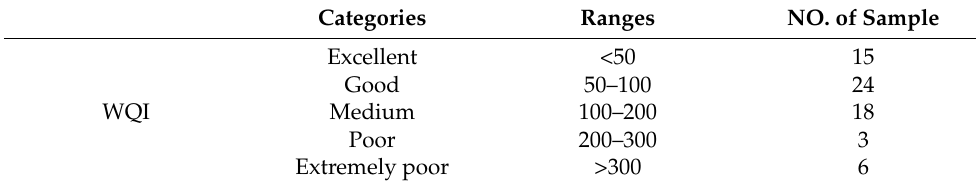
Table 3. Quality classification of phreatic water and confined water. Categories